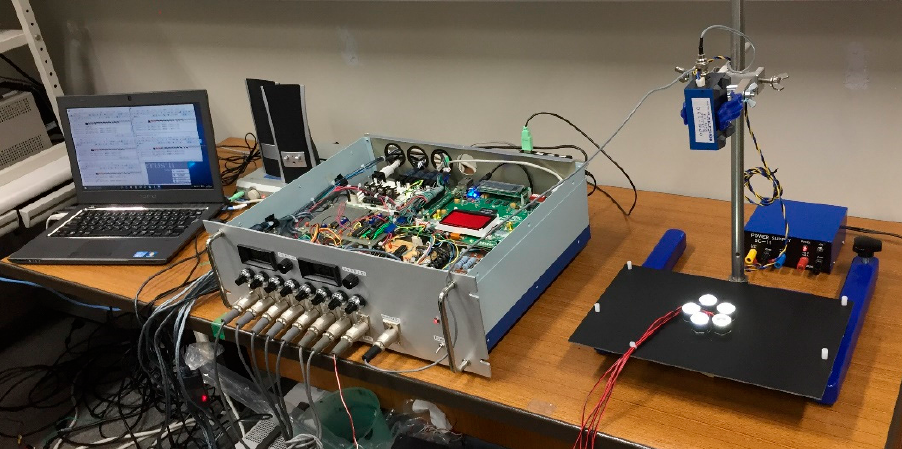
Figure 8. Visible-light CDMA experimental system using the proposed scheme.